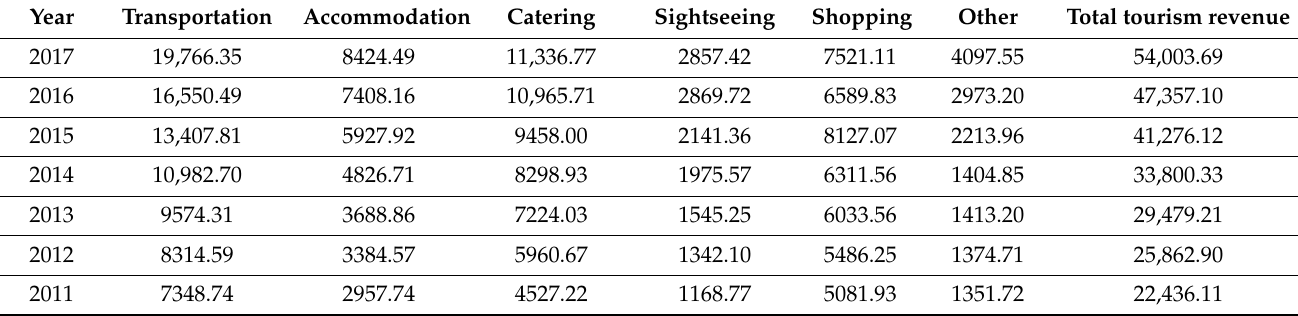
Table 2. Statistics of the tourism order parameters from 2011–2017(Unit: CNY 100